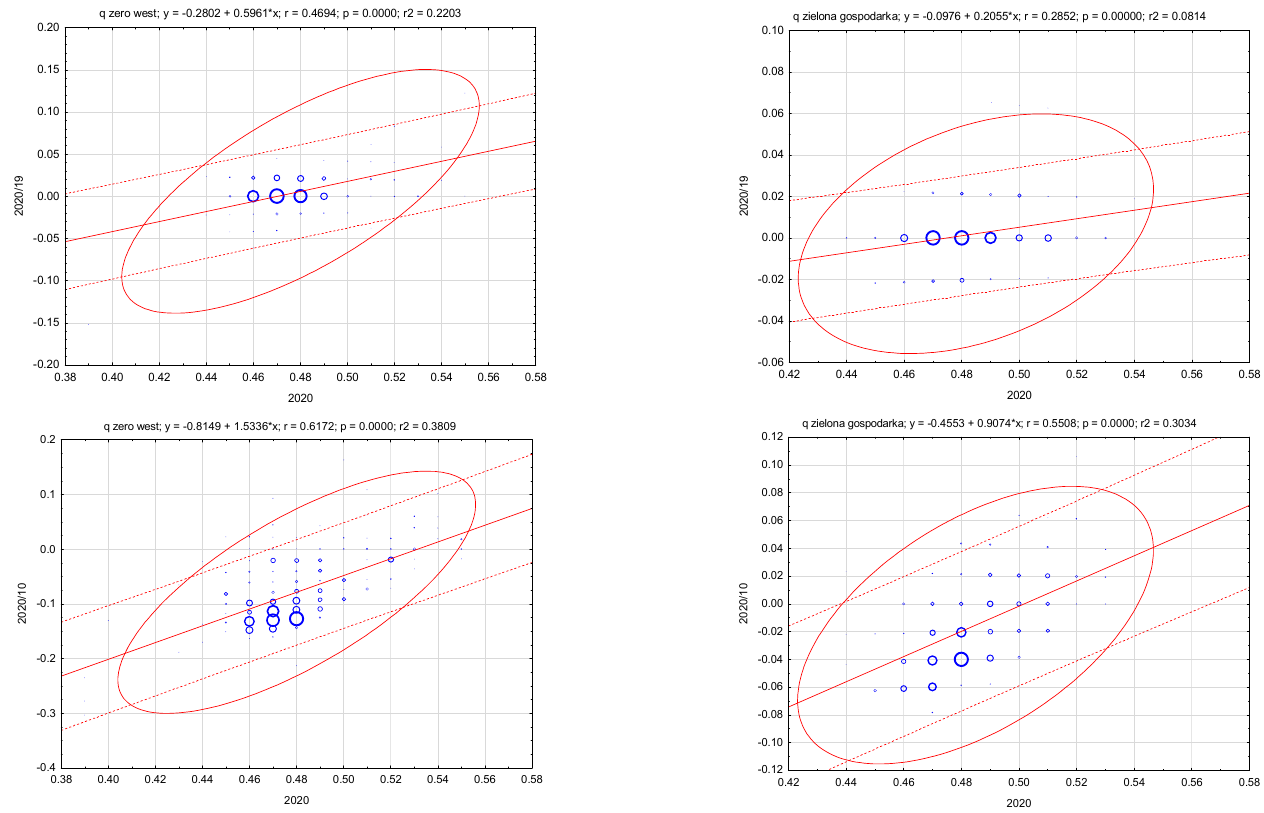
Figure 7. Relation of the synthetic measure, waste management and green economy and their changes in districts in Poland. Source: own study based on the BDL CSO data.